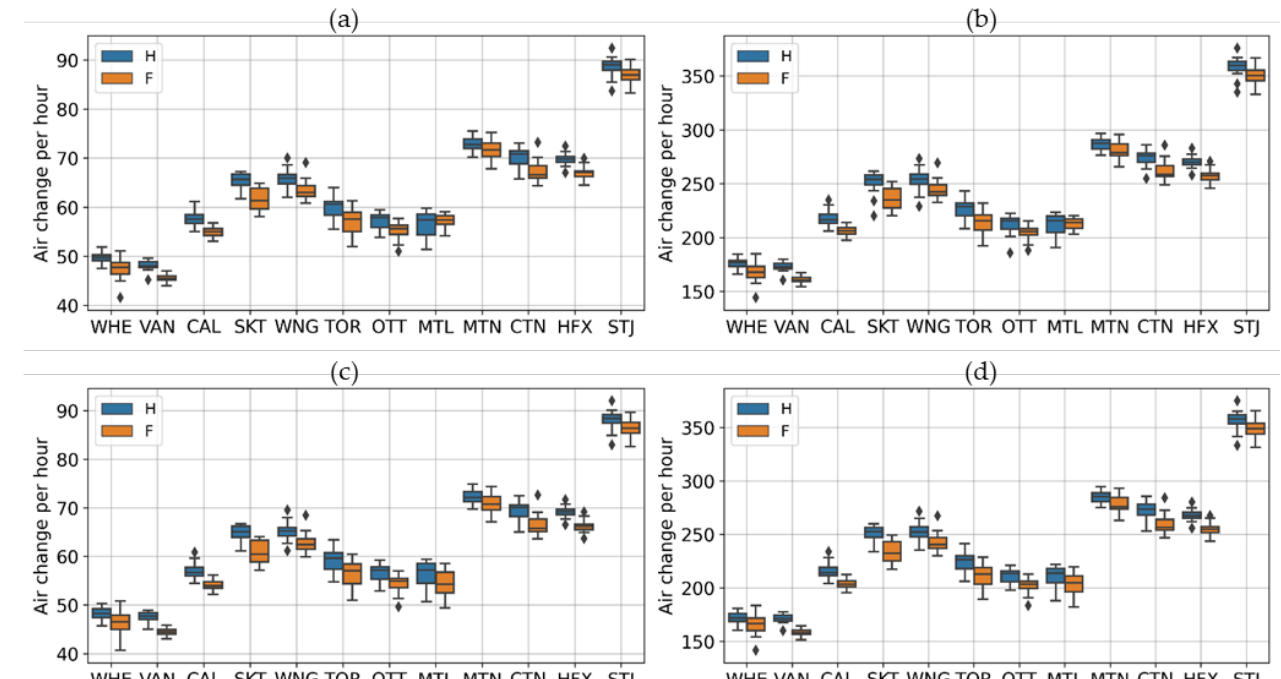
Figure 7. Boxplots of the median hourly values of air change per hour (ACH) for historical (H) and future periods (F): ( a ) FCB, vented; ( b ) FCB ventilated; ( c ) ACM vented and ( d ) ACM ventilated. Each box shows the variation of ACH values obtained with the test year for the 15 climate realizations in each time period.